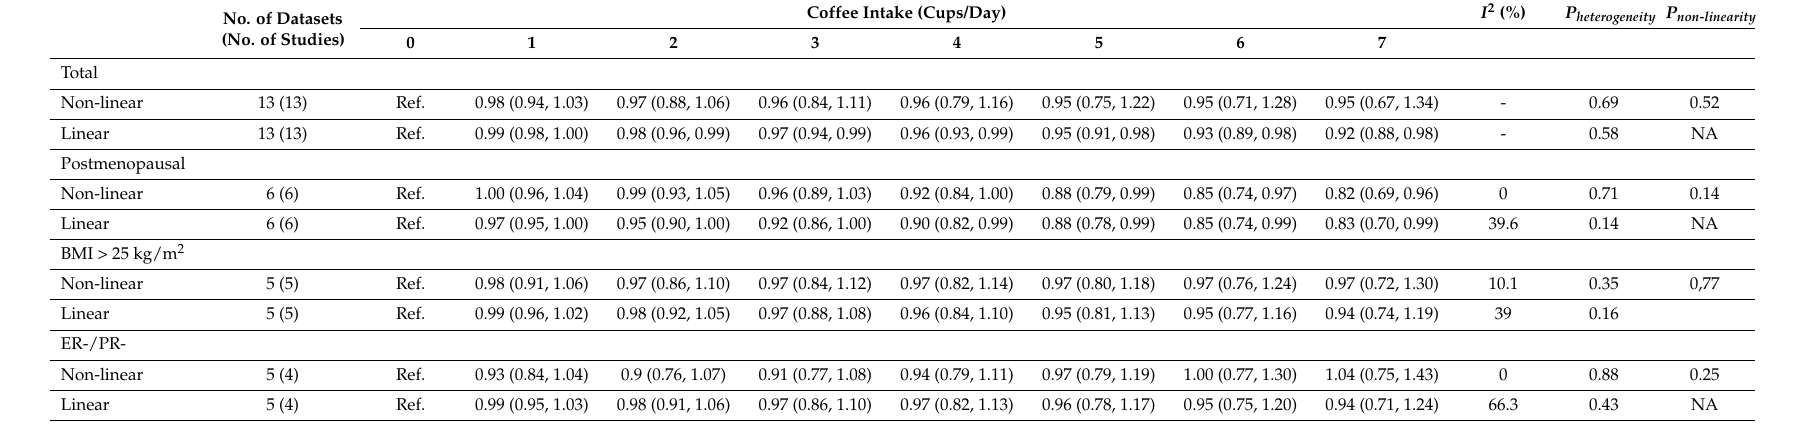
Table 3. Dose-response meta-analysis of prospective cohort studies on coffee consumption and breast cancer